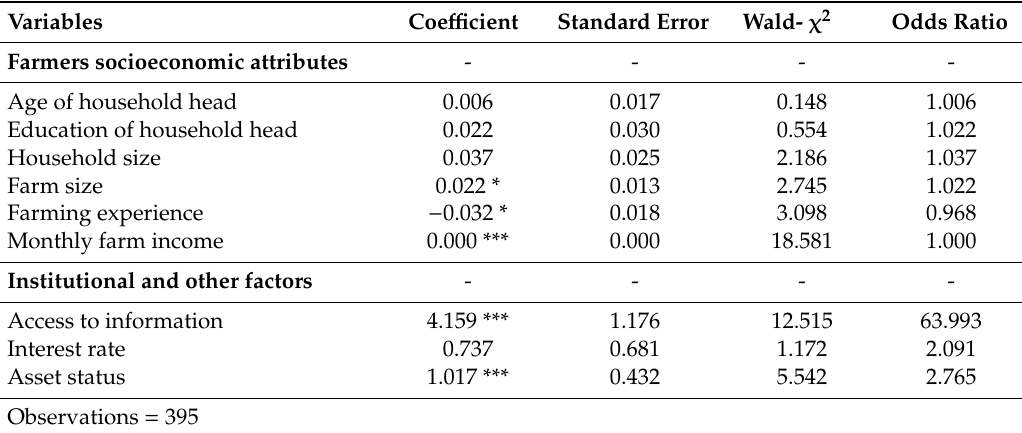
Table 3. Results of binary logit